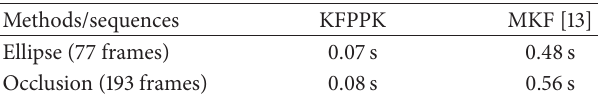
Table 1: The average time by different methods on the videos